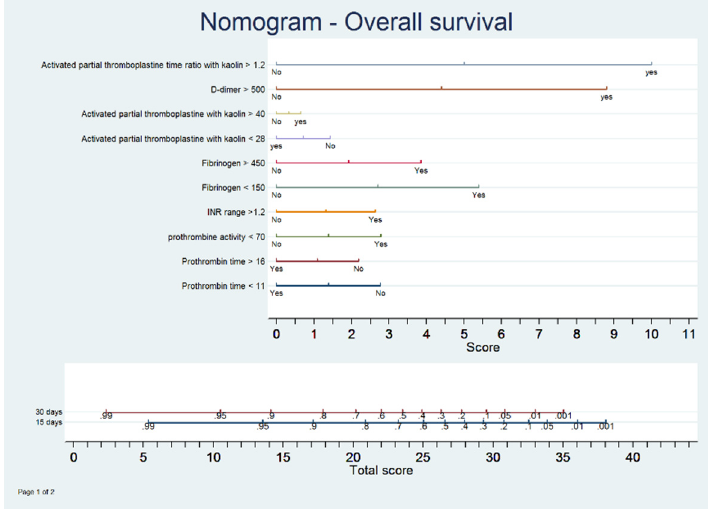
Figure 7. Nomogram. Figure 7.